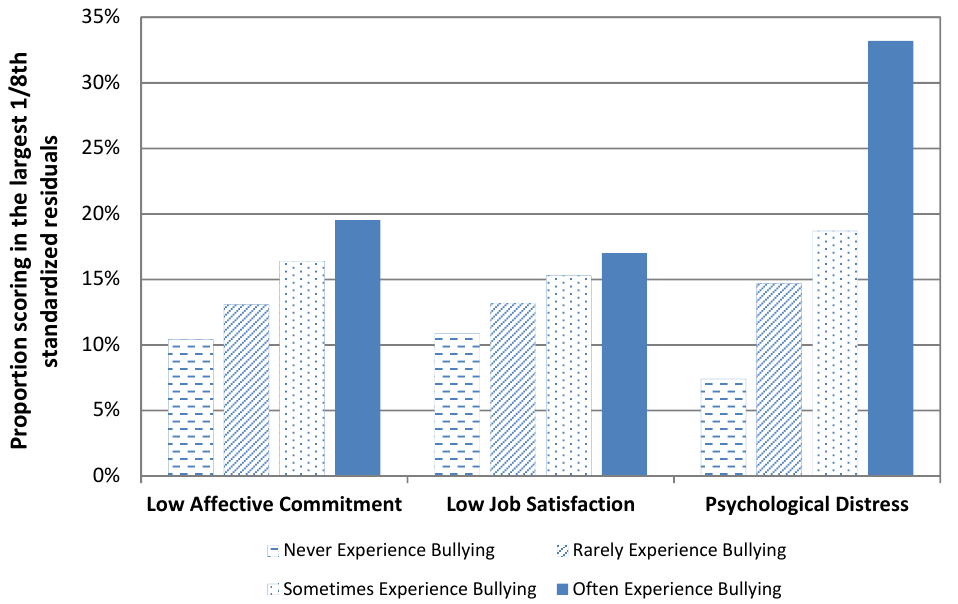
Figure 1. Relationships between frequency of experiencing workplace bullying and standardized residuals of (low) a ff ective commitment, (low) job satisfaction, and (high) psychological